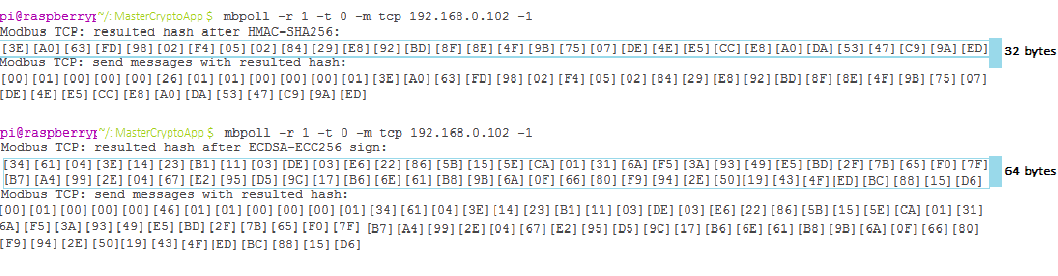
Figure 5. HMAC-SHA256 and ECDSA ECC-256 additional size introduced for the Modbus TCP